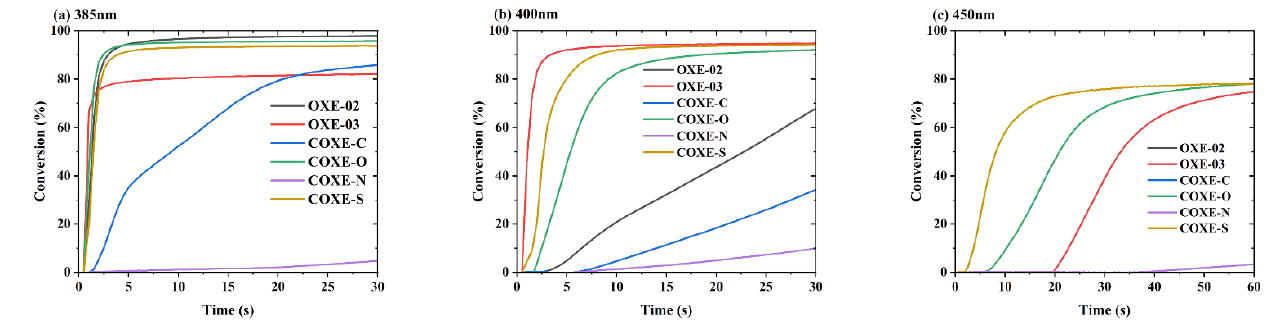
Figure 7. C=C double bond conversion curves for TPGDA polymerization initiated by COXEs, OXE- 02 and OXE-03 (4.8 × 10 − 5 mol · g − 1 ) under ( a ) 385 nm, ( b ) 400 nm and ( c ) 450 nm LED irradiation for 30 s (LED light intensity: 100 mW · cm − 2 ).